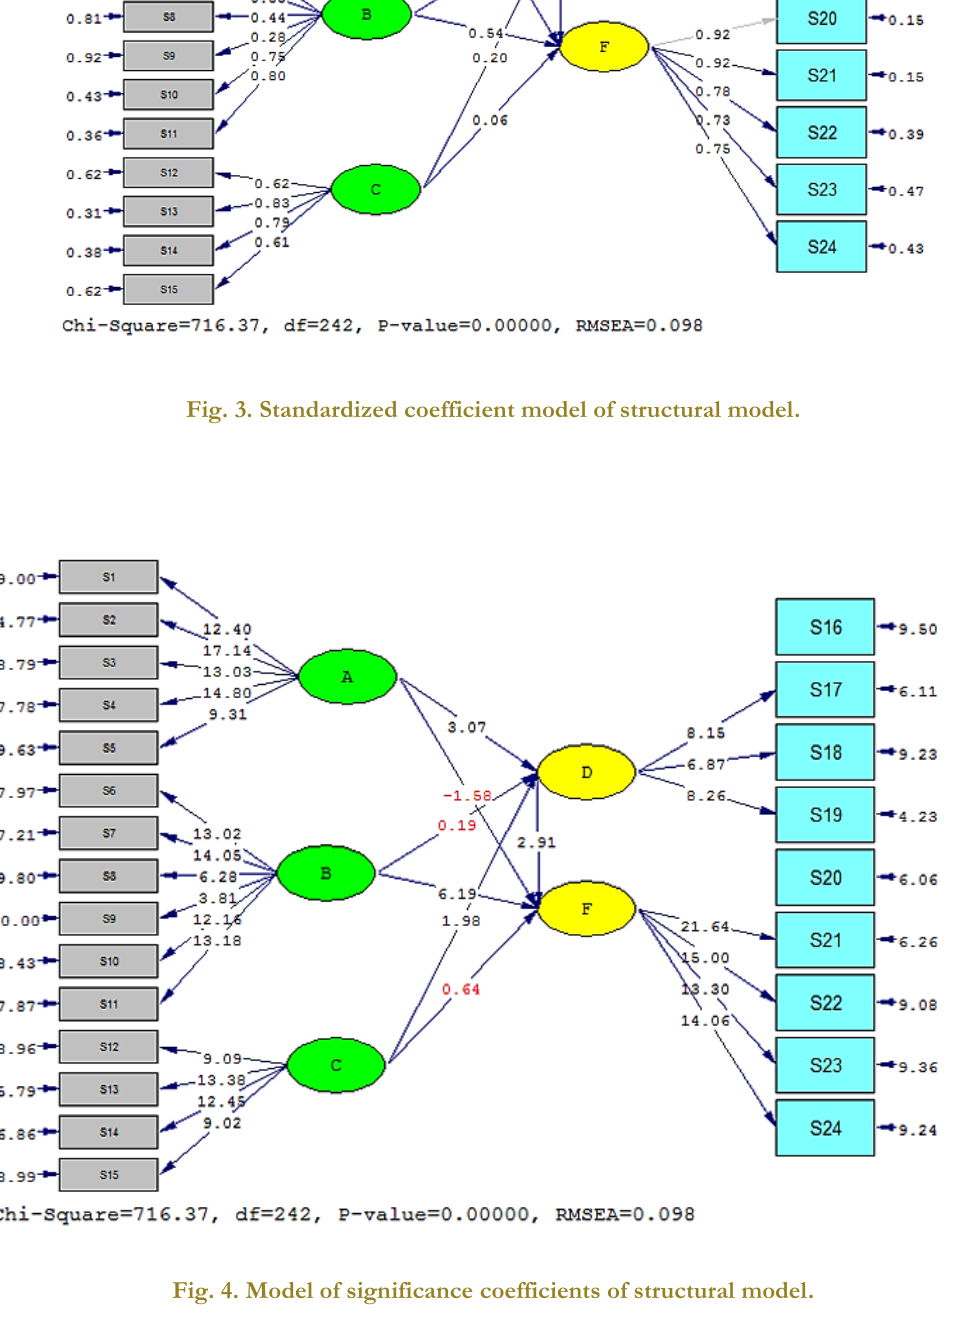
Fig. 4. Model of significance coefficients of structural